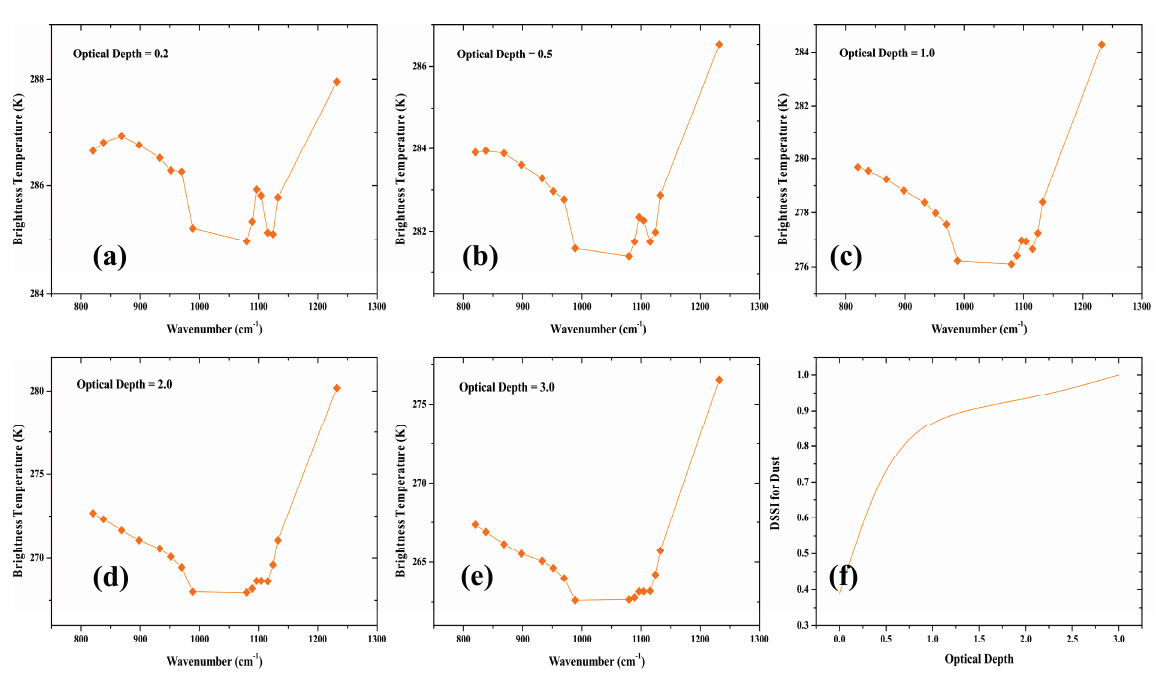
Figure 3. ( a–e ) The simulated nadir-viewed spectral brightness temperatures of selected AIRS channels for five different dust optical depths (0.2, 0.5, 1.0, 2.0 and 3.0). ( f ) The variation trend of DSSI under the condition of